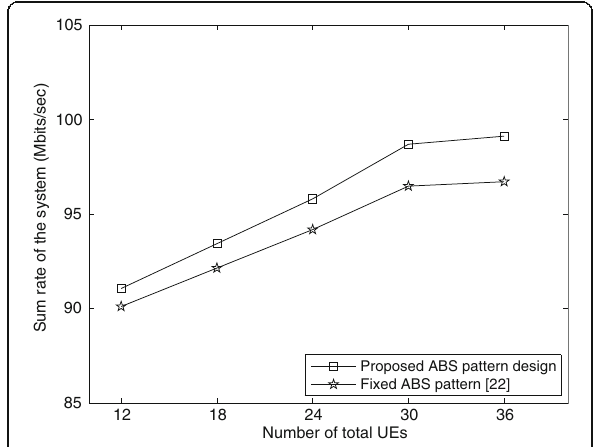
Fig. 6 Comparison of the sum rate of the system, in respect to Fig. 5